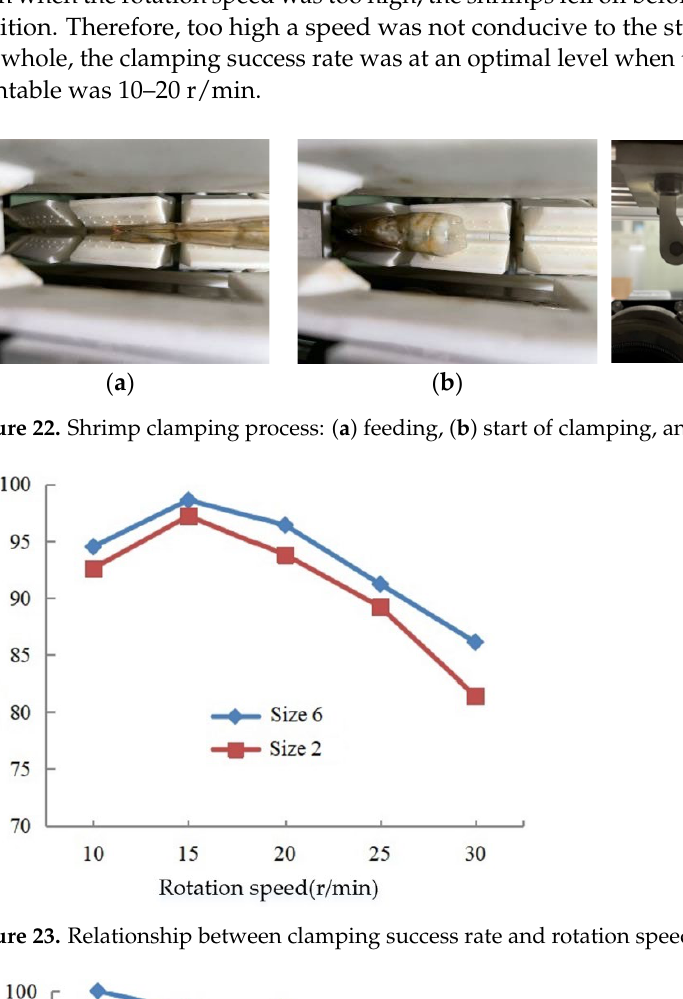
( b ) Figure 21. Change curve of contact force of clamping plate in Z direction: ( a ) front clamping plate, and ( b ) rear clamping plate. According to analysis of the curve changes in Figure 21, the overall change laws of the contact forces of the front and rear clamping plates were the same: as time passed by, the contact force was first at a lower value, then gradually increased to the maximum value, and then remained at the maximum value. The time point when the contact force of the front clamping plate reached the maximum value was 0.9 s, and for the rear clamp- ing plate it was 1.6 s. The time points of the two successively coincided with the time points of the two clamping units leaving the track, indicating that the clamping force of the clamping plate on the shrimp was small before reaching the clamping position; more- over, the clamping plate gradually closed after reaching the clamping position, and the clamping force increased rapidly. After the force of the shrimp was balanced, the clamp- ing force remained stable. According to the contact force data, the maximum contact force of the front and rear clamping plates were 7.9 N and 9.3 N, respectively. Since the position of the front clamping plate holding the shrimps was inclined to the tail, and the position of the rear clamping plate holding the shrimps was inclined to the head, the different